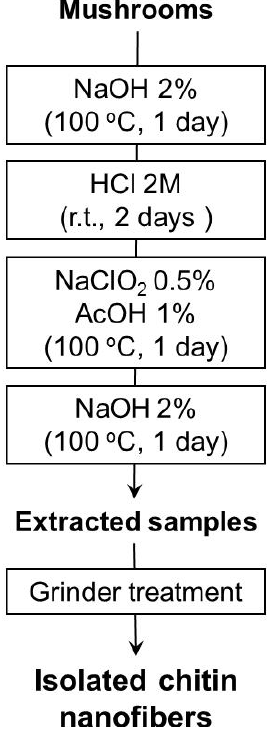
Figure 2. Preparation procedure of chitin nanofibers from